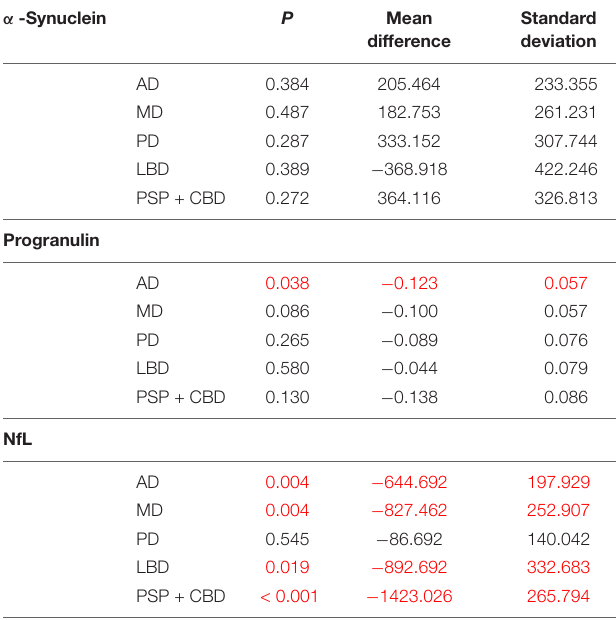
TABLE 2 | t -test of cerebrospinal fluid (CSF) biomarkers compared with non-neurodegenerative